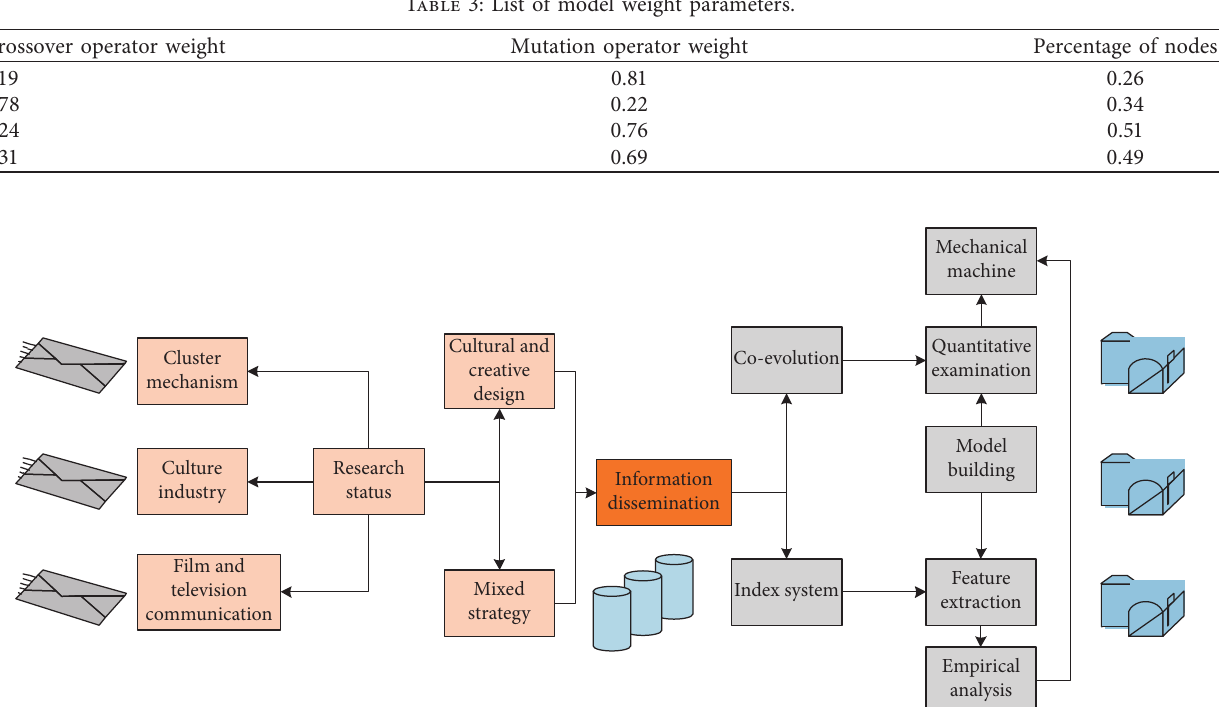
Figure 2: The framework of the cultural communication model based on evolutionary game theory.